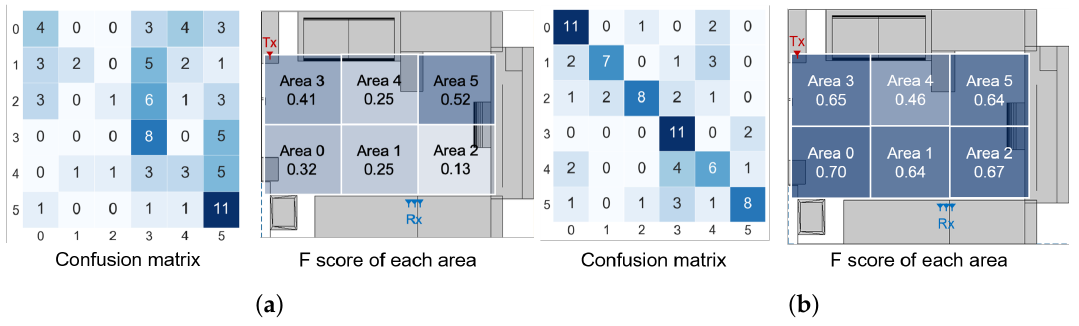
Figure 13. Features of the small office. ( a ) Existing method. ( b ) Proposed method.